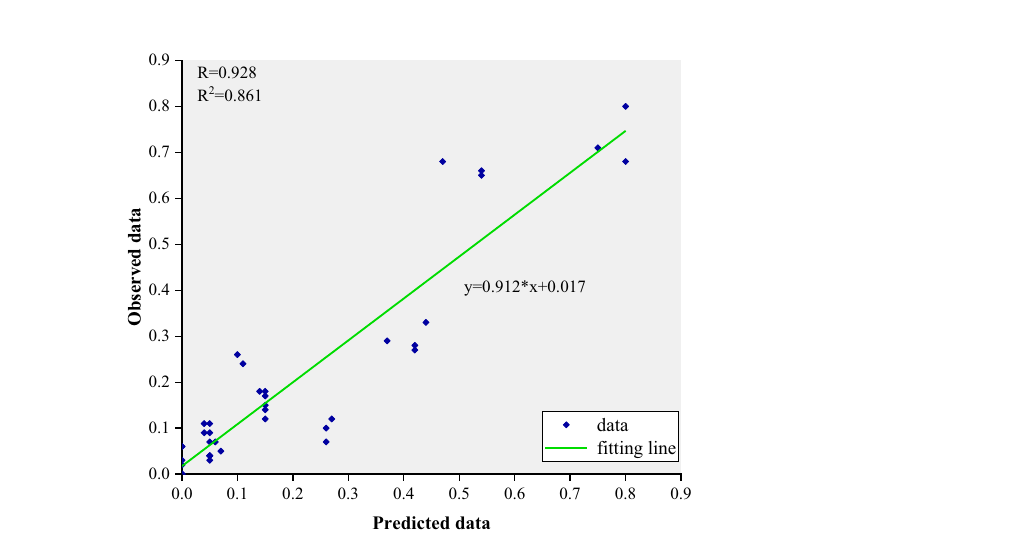
Figure 7. Scatter plot of predicted versus obtained fixation probability of each AOI for all